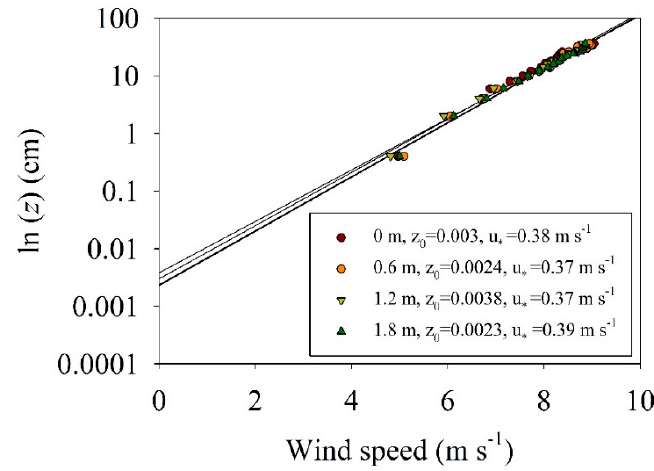
Figure 1. Photograph of the wind tunnel used in this study.